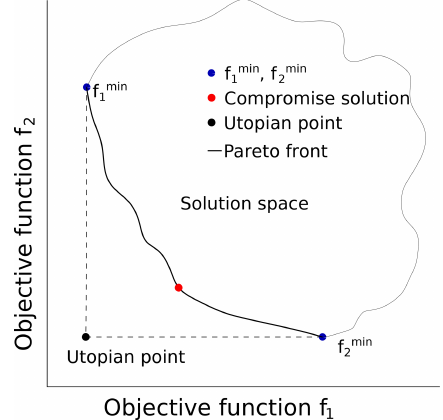
Figure 3. The figure displays a 2-dimensional Pareto space which comprises a 2-dimensional Pareto front. The solutions on this front (black solid line) are referred to as the non-dominated set of so- lutions. In comparison, all other solutions within the solution space are inferior in at least one objective relative to the Pareto front. Clas- sic single objective optimization yields the points f min which represent the minimum of those objectives that the model can achieve. The utopian point (black) is the point ( f min where both objectives are at their minimal value. Commonly, the compromise solution (red) of the Pareto set is considered an objec- tive choice for a single solution as it has the minimum Euclidean distance of the optimal solution towards the utopian